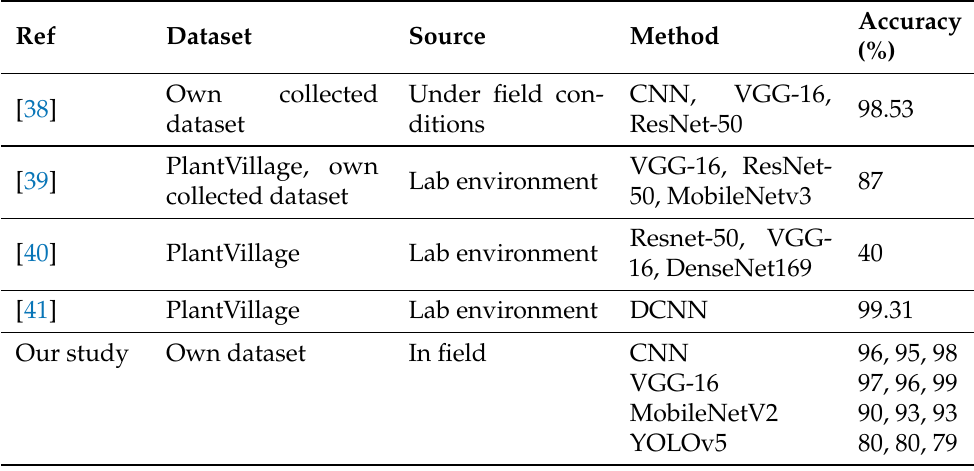
Table 5. A comparison with the previous work. The last column indicates the results of each adopted algorithm on pest pattern, nutrient deficiency, and soft rot disease